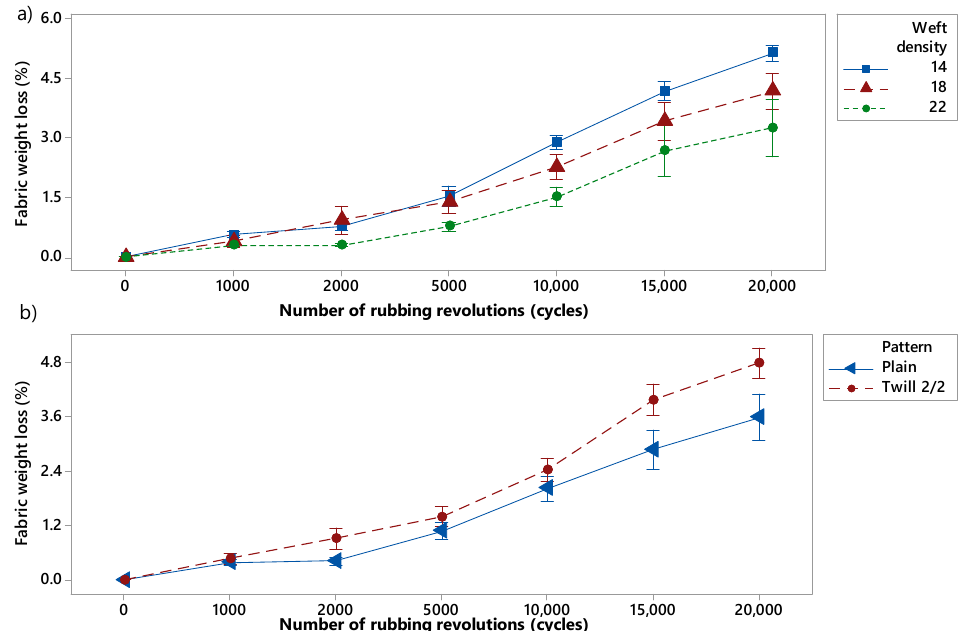
Figure 4. Relationship between fabric weight loss (%) prior to Fused Deposition Modeling (FDM) process and number of rubbing cycles when varying ( a ) the weft density and ( b ) the pattern. The 14, 18, 22 picks/inch are in blue, red and green, respectively) and the plain and twill patterns are in blue and red, respectively.